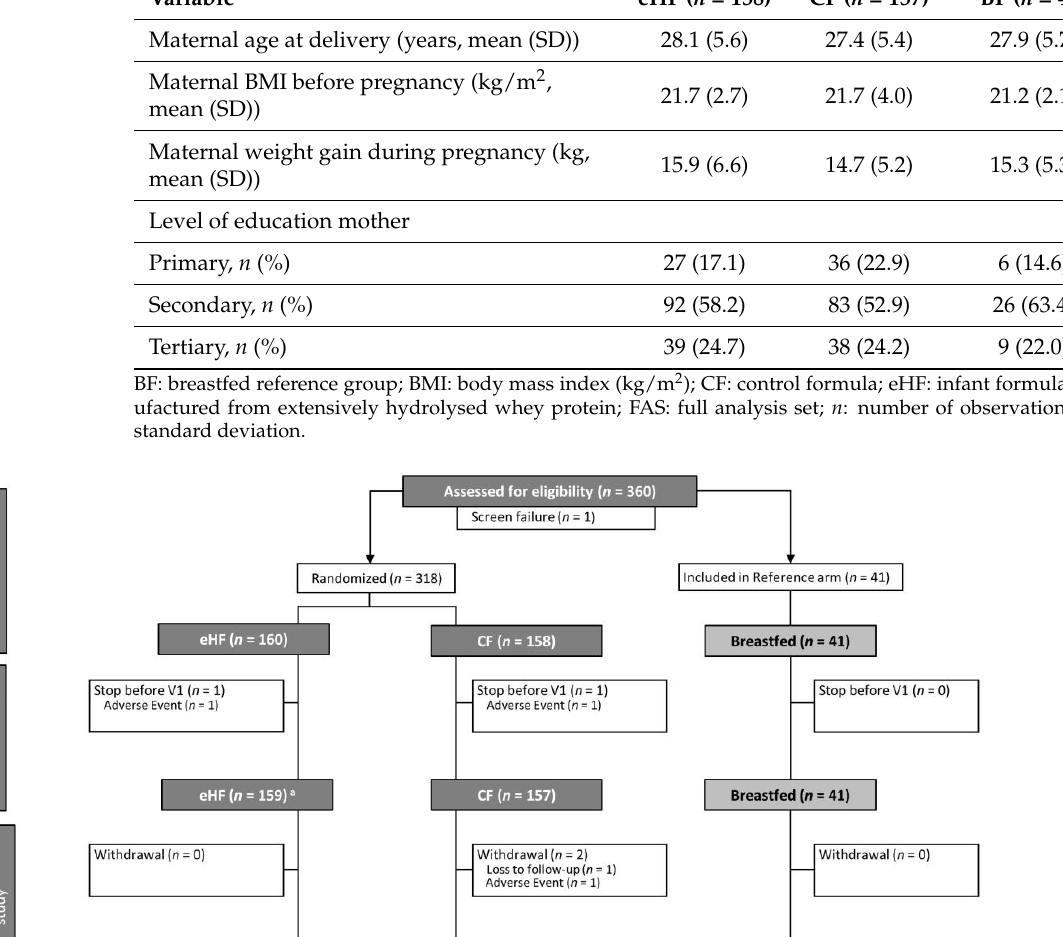
Table 2. Birth characteristics, demographic and social factors (FAS). Variable